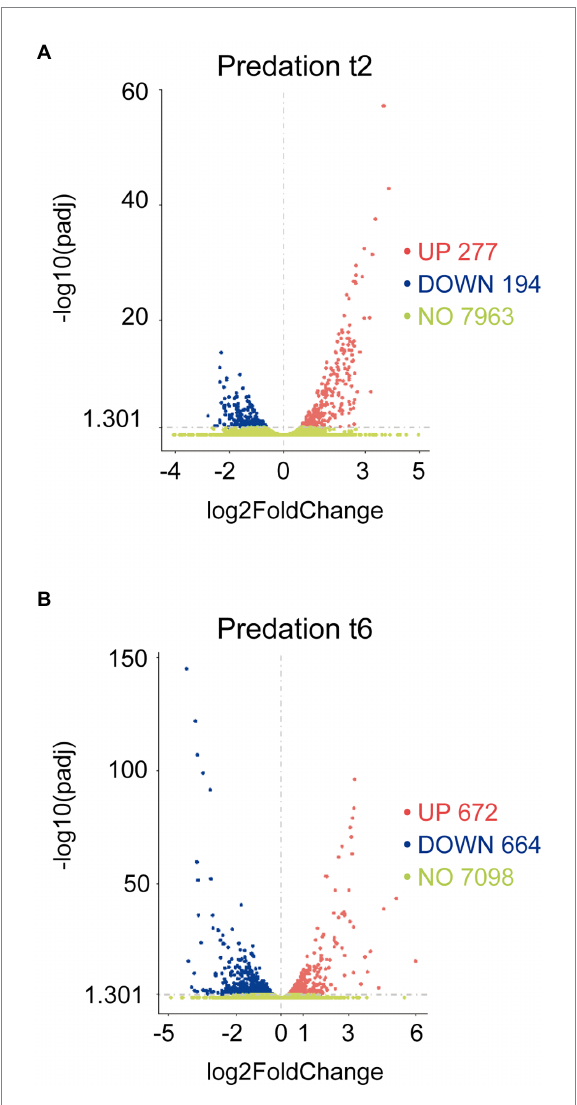
FIGURE 1 Differential expression response of M. xanthus during predation. Screening of differentially upregulated (A) and downregulated (B) genes by volcano at t2 and t6 in predatory conditions. Volcano plots show the estimated fold changes ( x -axis) versus the minus log10 of the adjusted p -values ( y -axis) from DEseq analysis. Significant genes with absolute values of |Log2 Fold Change|>0 and p adj<0.05 are shown in red (upregulated) or in blue (downregulated). Black vertical dotted line indicates zero- fold change. Green dots indicate non-regulated